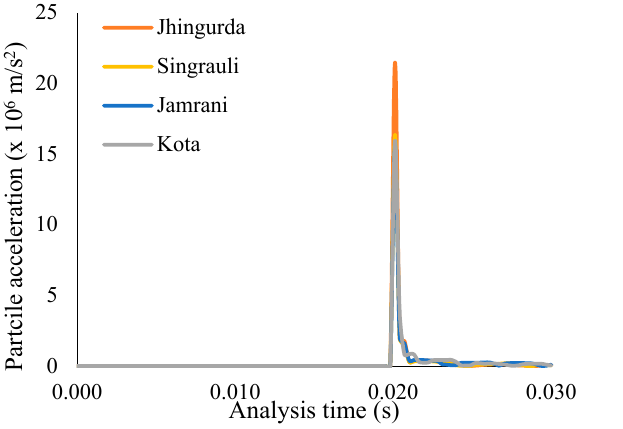
Figure 8. Comparison of particle acceleration at ground surface under present impact loading condition.